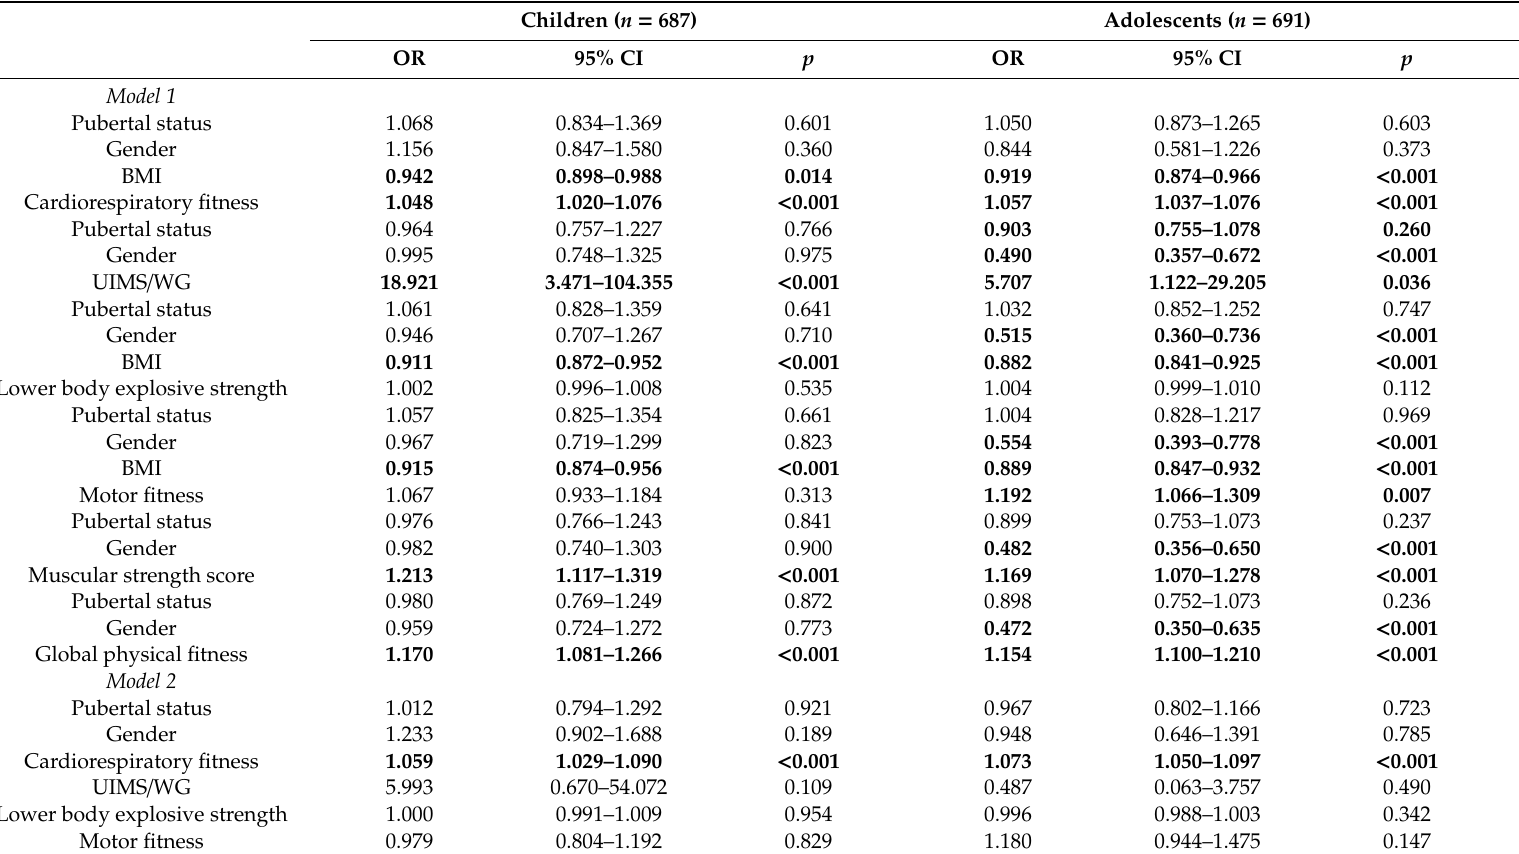
Table 2. Cumulative odd ratios and 95% confidence intervals for having high self-rated health according to physical fitness at